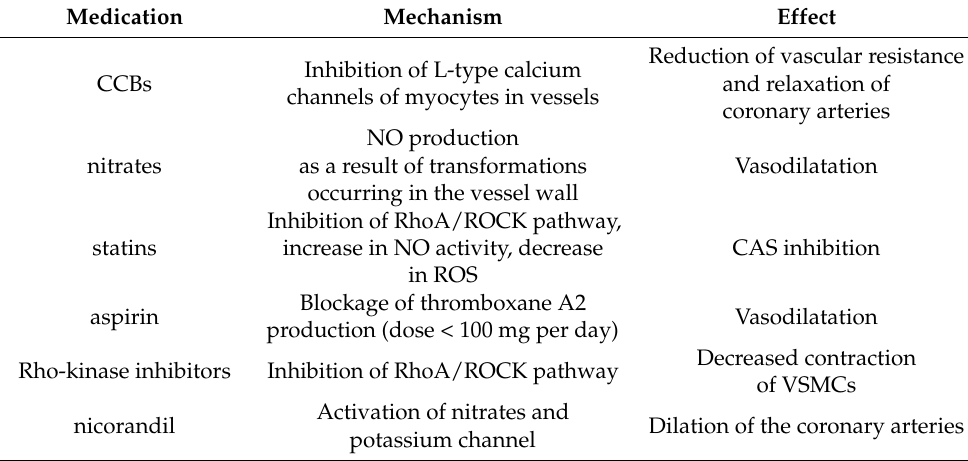
Table 4. Pharmacological treatment of CAS